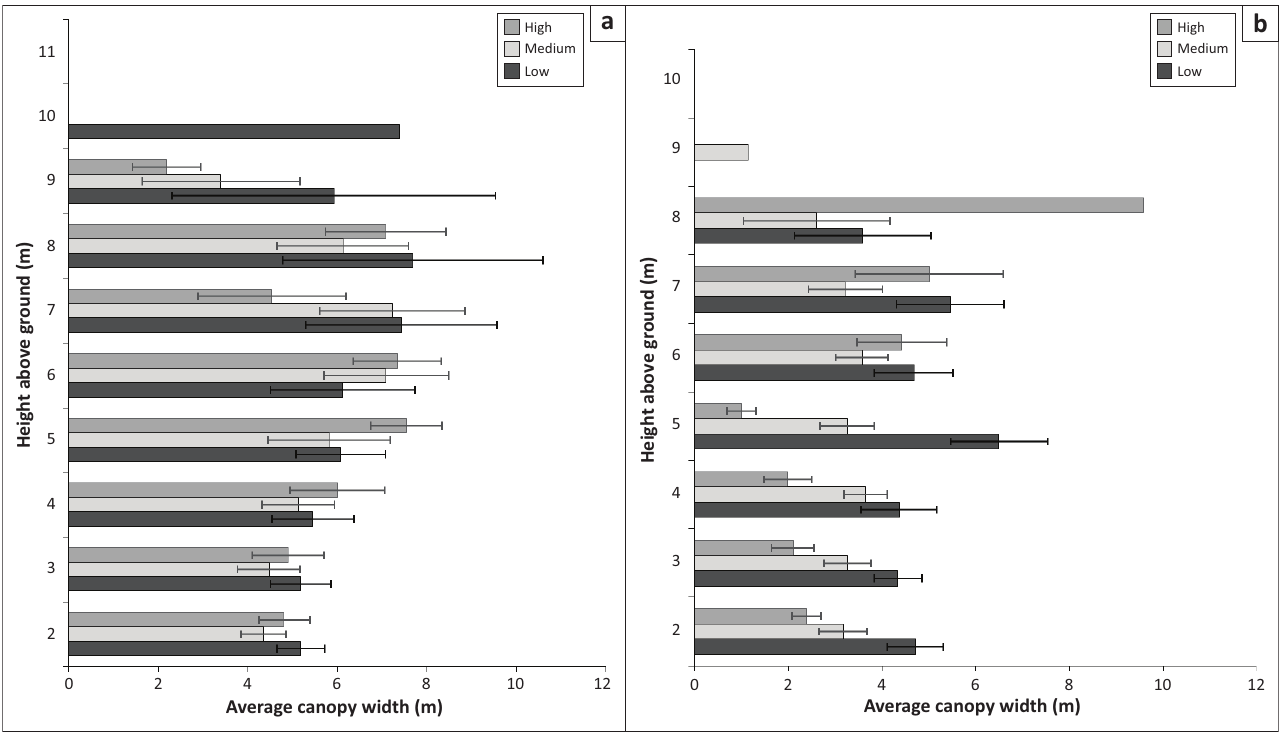
FIGURE 1: Average canopy width for (a) Vachellia erioloba and (b) Vachellia haematoxylon in the low, medium and high giraffe density